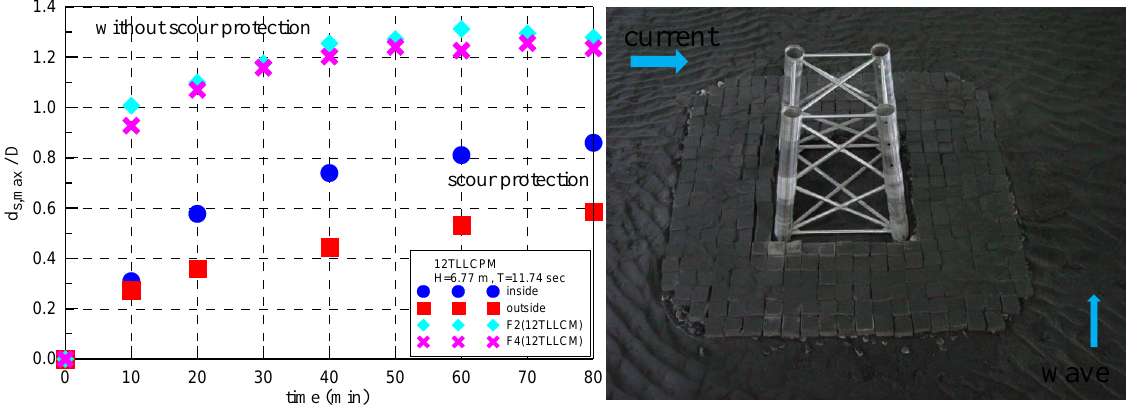
Figure 7. Comparison of maximum scour depth between the case, 12TLLCM (without scour protection), and the case, 12TLLCPM (with hard scour protection).